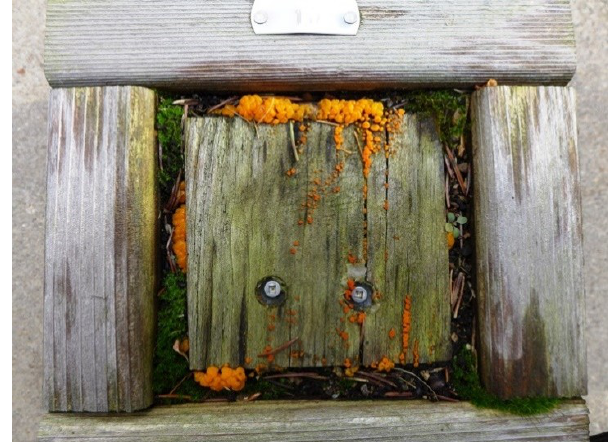
Figure 2. Visual example of untreated pine block at the end of the test. Note moss growth indicative of high moisture content and surface growth of saprophytic fungi on the surface of the block, presumably Dacrymyces spp. (likely capitatus